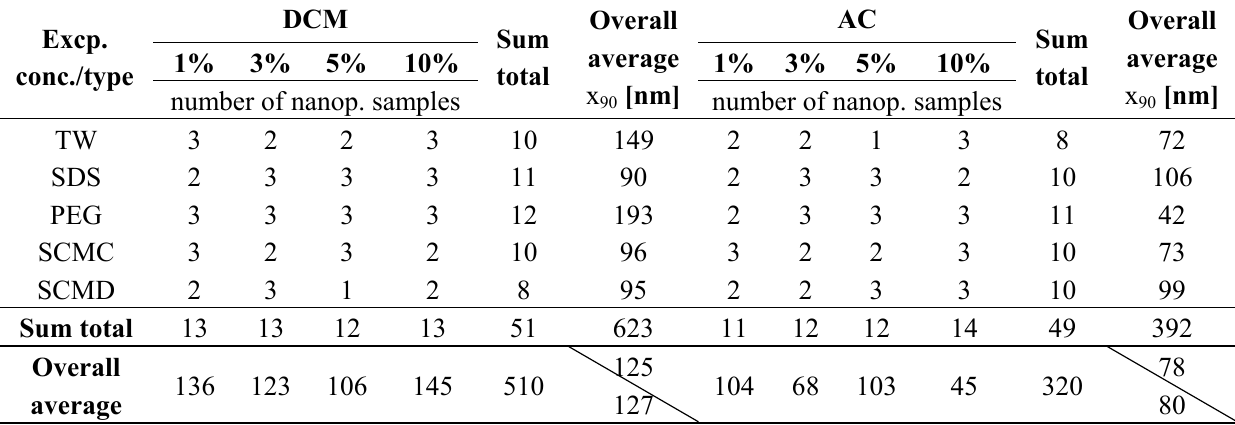
Table 6. View of formed samples of nanoparticles ( ≤ 900 nm) depending on solvents and type and amount of excipients. (conc. = concentration, excp. = excipient, dichloromethane =